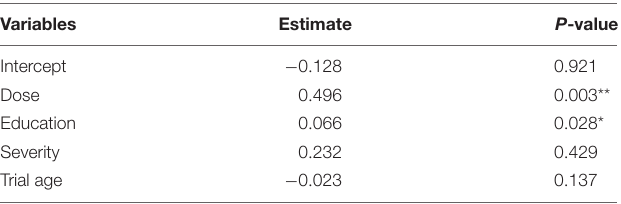
TABLE 4 | Linear mixed-effects analyses fixed effect estimates for mediation model.